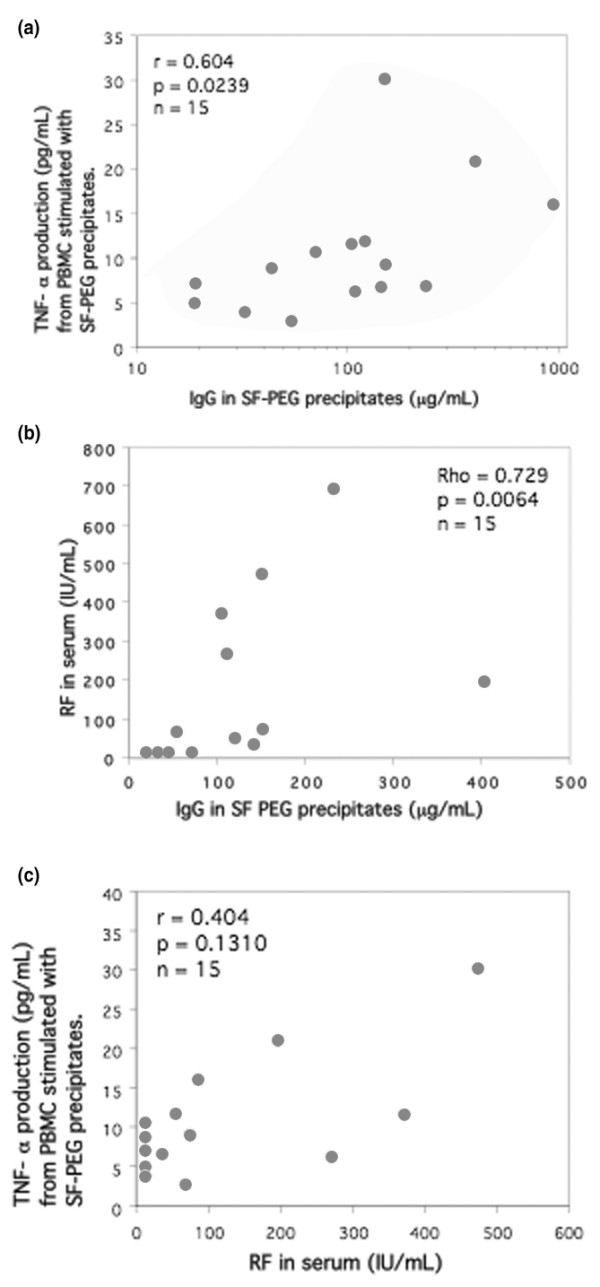
Correlation between SF precipitate induced TNF-α production, IgG levels in SF precipitates, and RF (n = 15). Healthy PBMCs were stimulated with PEG precipitates from SF from 15 patients with RA. The stimulated cells were cultured for 20 hours at 37°C with 5% carbon dioxide. IgG levels in the SF precipitates correlated with (a) TNF-α production after SF PEG stimulation and (b) RF measured in serum. (c) There was also a nonsignificant positive correlation between RF and TNF-α induced by SF PEG precipitates. Statistical analyses were performed with nonparametric tests to diminish the effect of outliers. PBMC, peripheral blood mononuclear cell; PEG, polyethylene glycol; RA, rheumatoid arthritis; RF, rheumatoid factor; SF, synovial fluid; TNF, tumour necrosis factor.